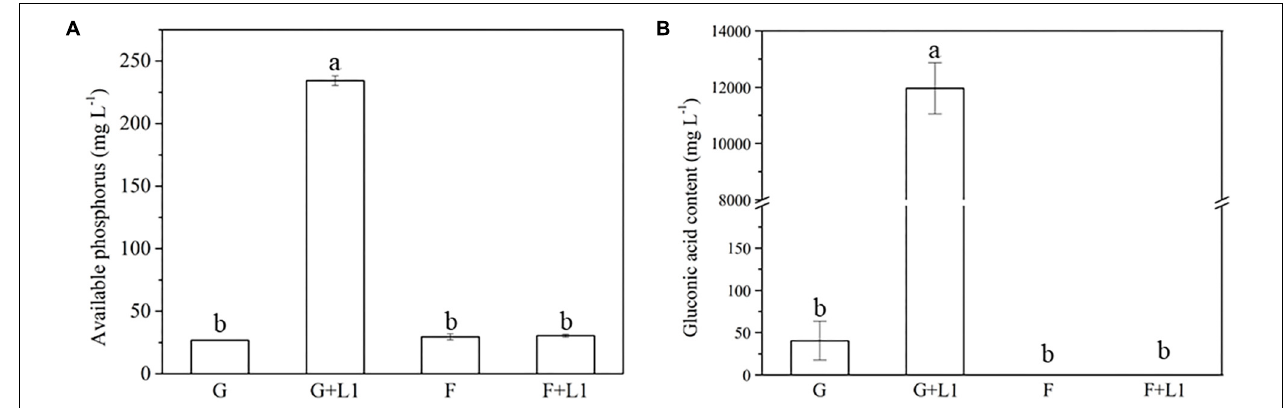
FIGURE 7 | Effects of carbon source on Al-P solubilization and gluconic acid secretion. (A,B) Concentrations of available P (A) and gluconic acid (B) in culture medium containing different carbon sources. Al-P-containing medium with or without added Nguyenibacter sp. L1 was cultured at 30 ◦ C for 48 h in the presence of glucose (G) or fructose (F), and the concentrations of available P and gluconic acid were determined. Vertical bars represent standard deviations of the means ( n = 3). Different lowercase letters above columns indicate significant differences ( p < 0.05) among treatments.